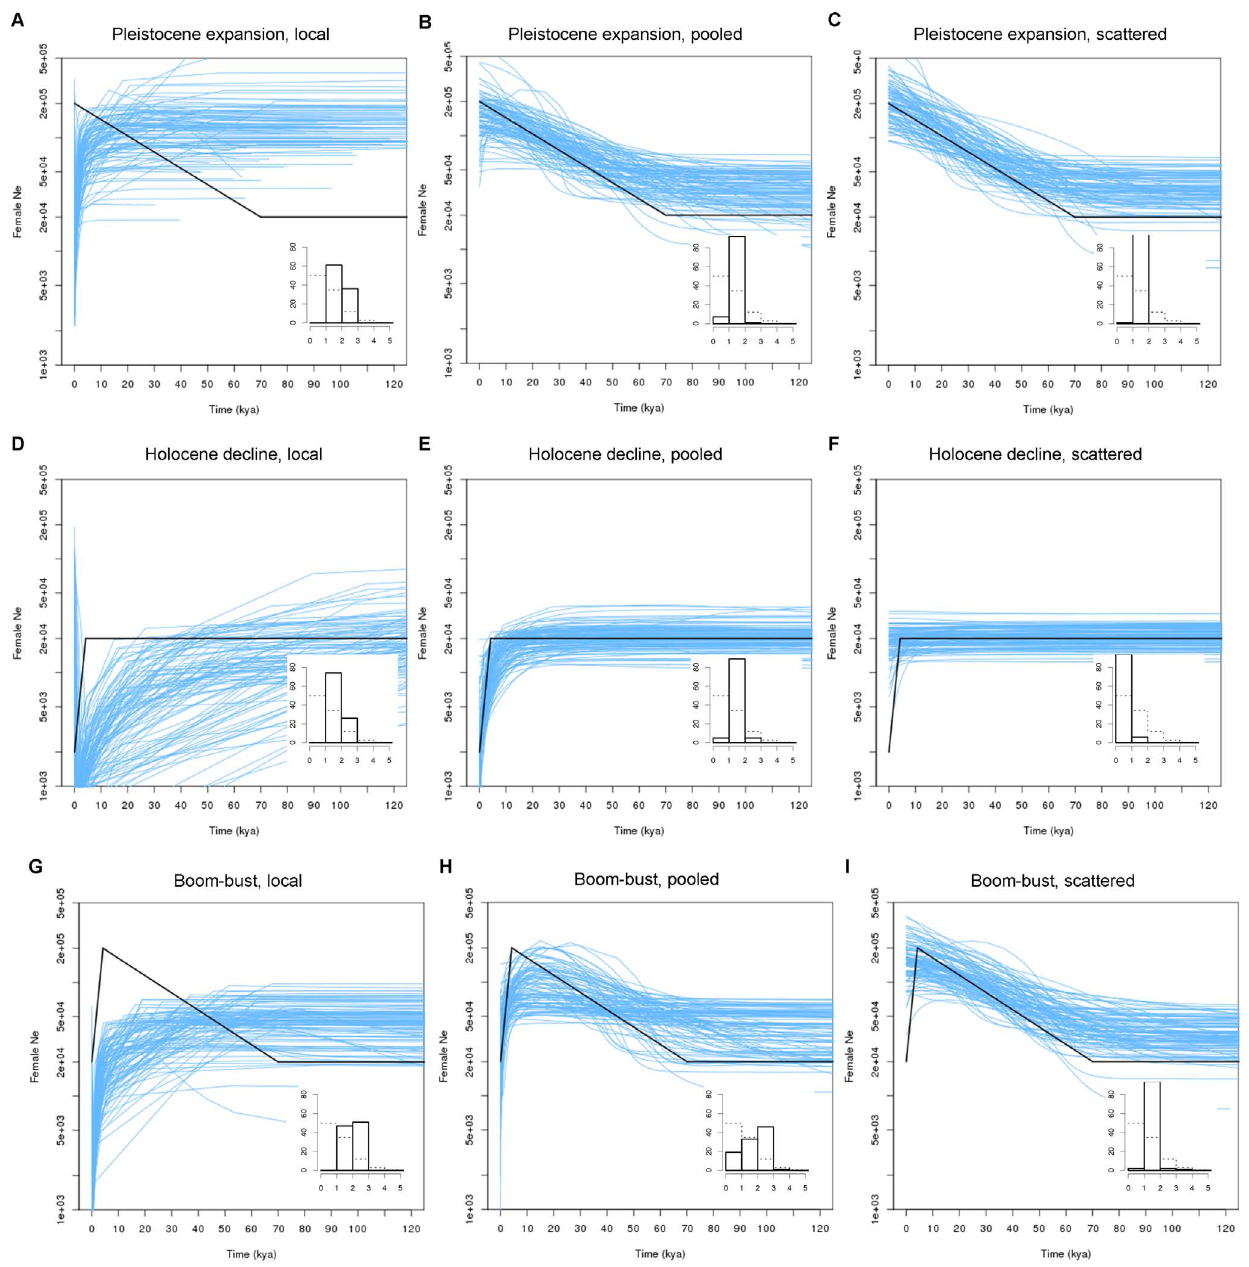
Figure 2. The structure effect in a 40-deme island model with demographic change. As Fig. 1, but the bold black line shows the simulated demographic change scenarios (see main text) with one or two changes in population size. Only the intermediary level of gene flow (N f m=1.25) is shown.